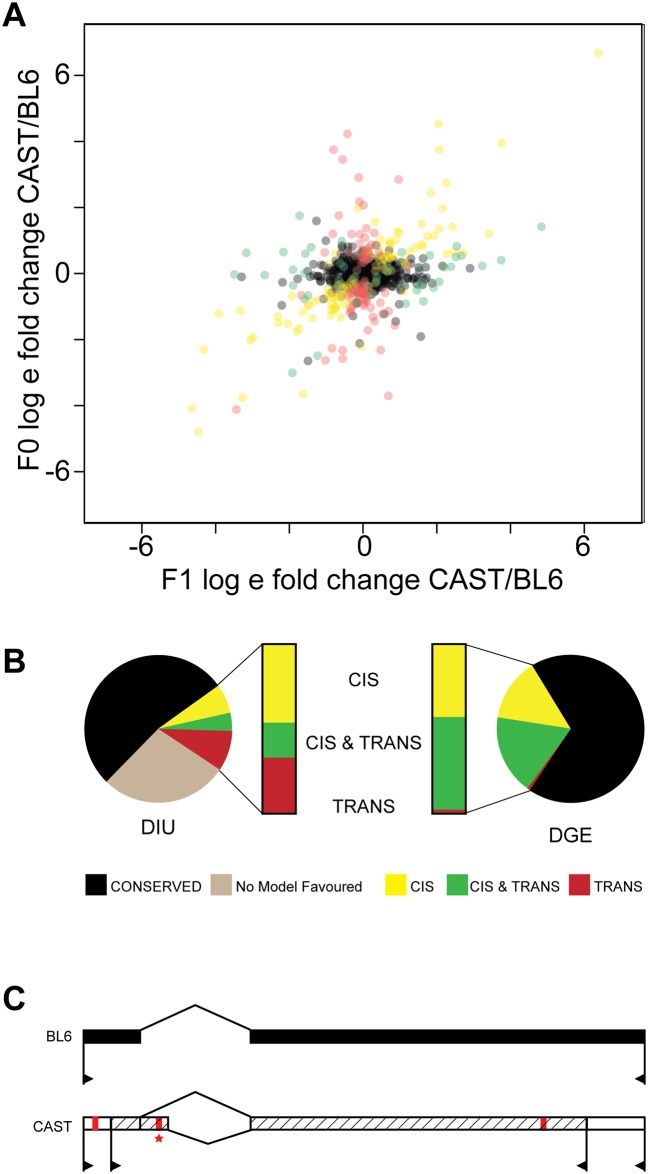
Divergent Isoform Usage is caused equally by regulatory changes in cis and in trans.Genes were classified according to the mechanism underlying their DIU: conserved, regulatory changes in cis, in trans, in cis & in trans, or genes where no model was significantly favored over the rest (A) Scatterplot shows each heterozygous gene expressing exactly two isoforms in liver, plotting the mean fold change in the ratio of CAST to BL6 transcript expression in the F0 (F0 BL6 v F0 CAST) against the F1 (BL6 allele in F1 v CAST allele in F1), weighted by the inverse of the estimate variances (B) The relative contribution of cis and trans mechanisms towards transcriptome changes differed significantly between divergent isoform usage (DIU) and divergent gene expression (DGE) in the same sample set [28]. (C) Divergent isoform usage is encoded in cis to the Commd5 gene. In F1 hybrid offspring, the BL6 allele expresses a single transcript (Commd5-001, black) and the CAST allele expresses two transcripts (Commd5-001, white, and Commd5-002, hatched). Commd5-001 and Commd5-002 utilise different transcription start sites (>), alternative internal splicing, and discrete polyadenylation sites (<). SNV between BL6 and CAST are indicated in red. * Indicates rs32416751, predicted to disrupt the 5’ splice site in Commd5.